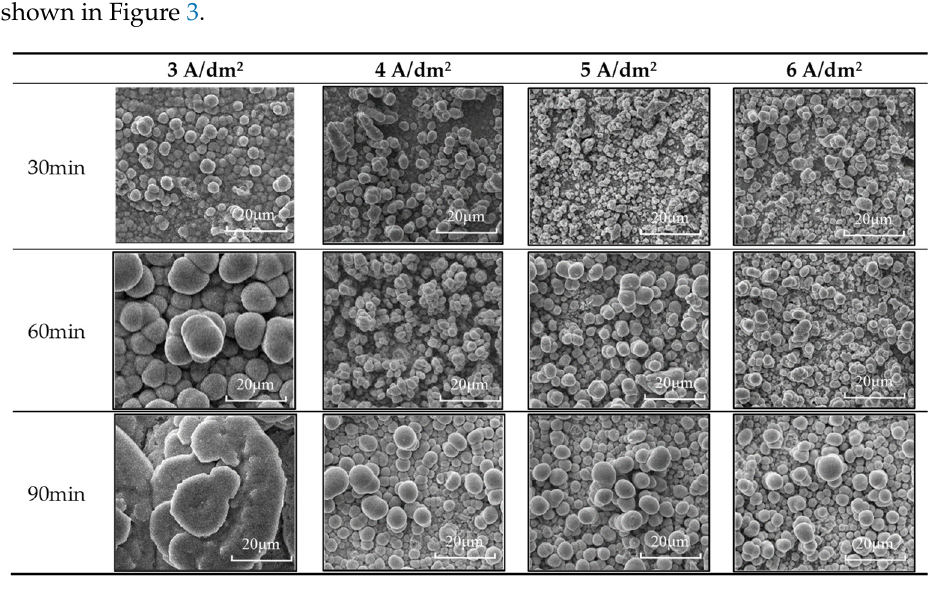
Figure 3. SEM images of samples were obtained with currents of 3–6 A/dm 2 and times of 30 min, 60 min, and 90 min. The scale bar is 20 μ m.